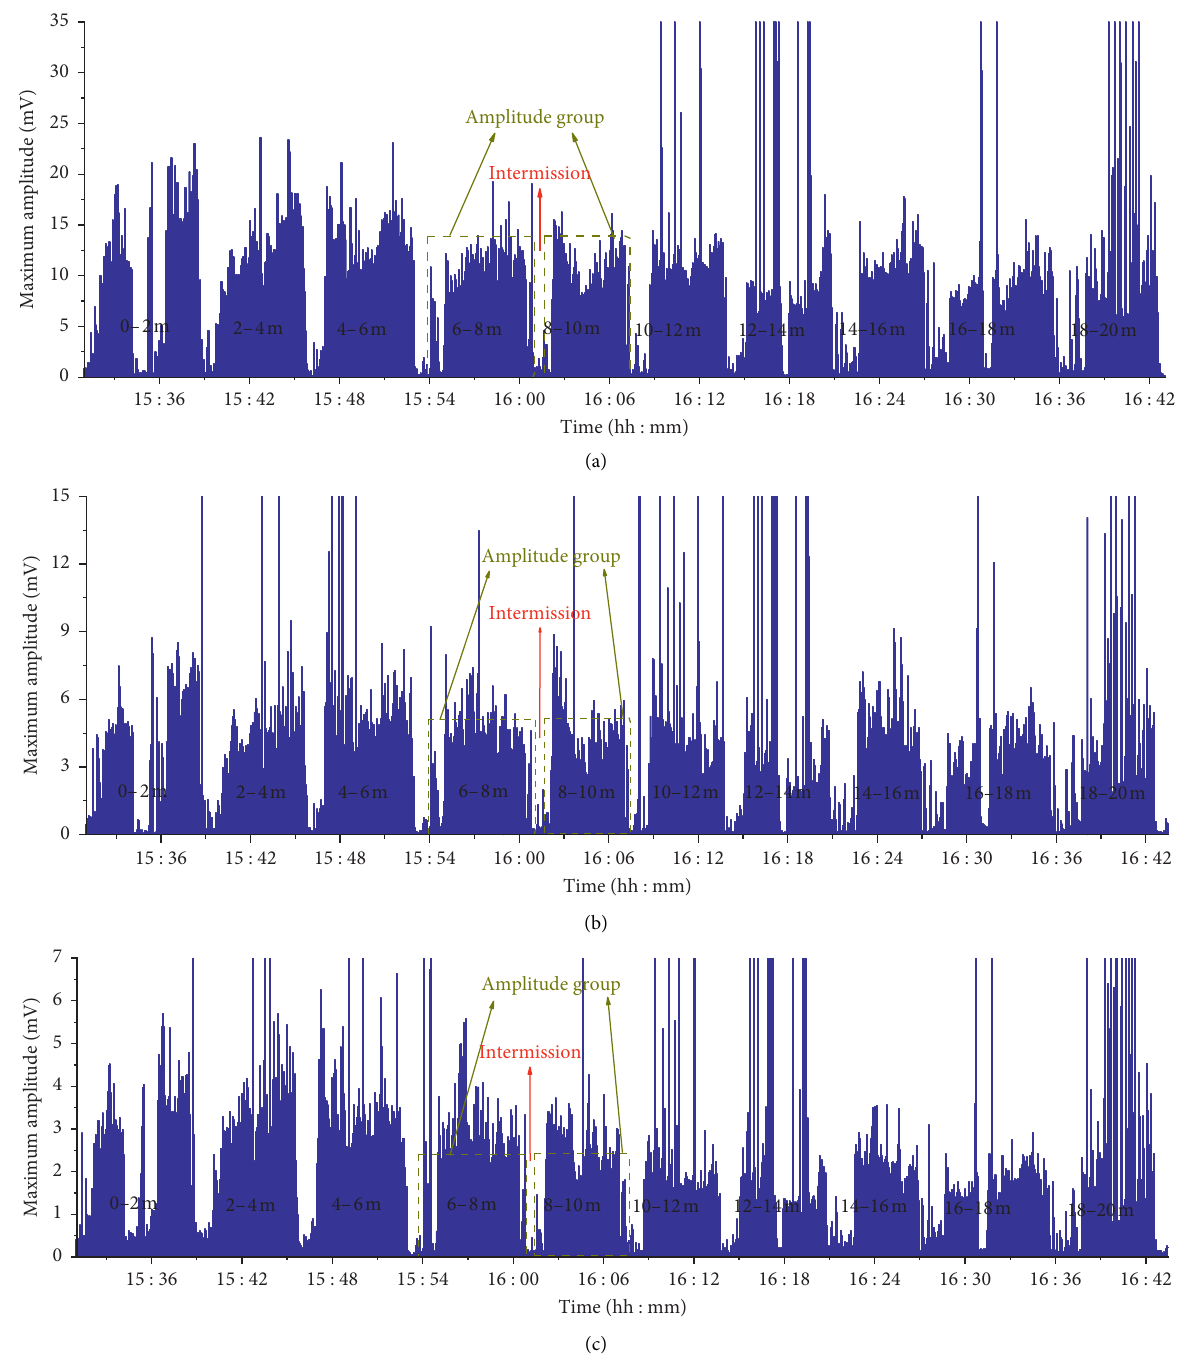
Figure 4: Amplification of maximum amplitude. (a) Amplification diagram of 1# detector. (b) Amplification diagram of 2# detector. (c). Amplification diagram of detector